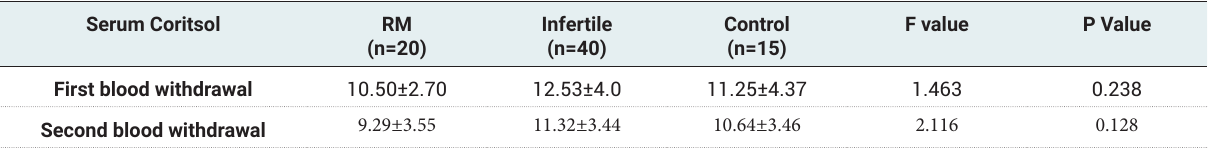
Table 2: Levels of serum cortisol in the first and second blood withdrawal.